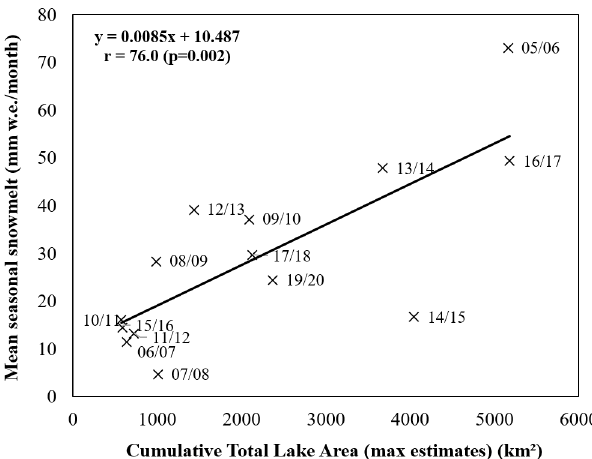
Figure 9. Scatter plot and correlation statistics of the relationship between mean seasonal RACMO melt and cumulative lake area over the study region per melt season.